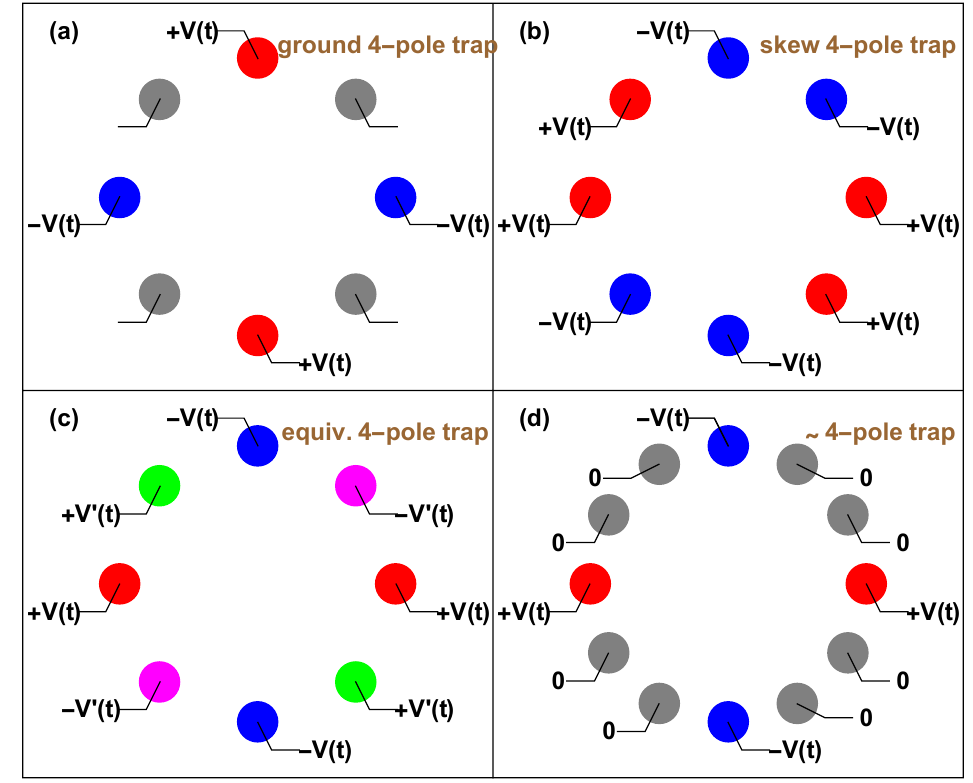
Figure 6. Alternate trap configurations for using an 8-pole or 12-pole setup as a modified quadrupole are shown. Panel ( a ) is an 8-pole structure with alternate electrodes explicitly grounded. Panel ( b ) shows a skewed quadrupole trap. Panel ( c ) shows an effective quadrupole trap with an 8-pole setup, where successive electrodes are at a phase difference of Pi/2. Finally, panel ( d ) shows a 12-pole structure, with a quadrupole field configuration and multiple shielding